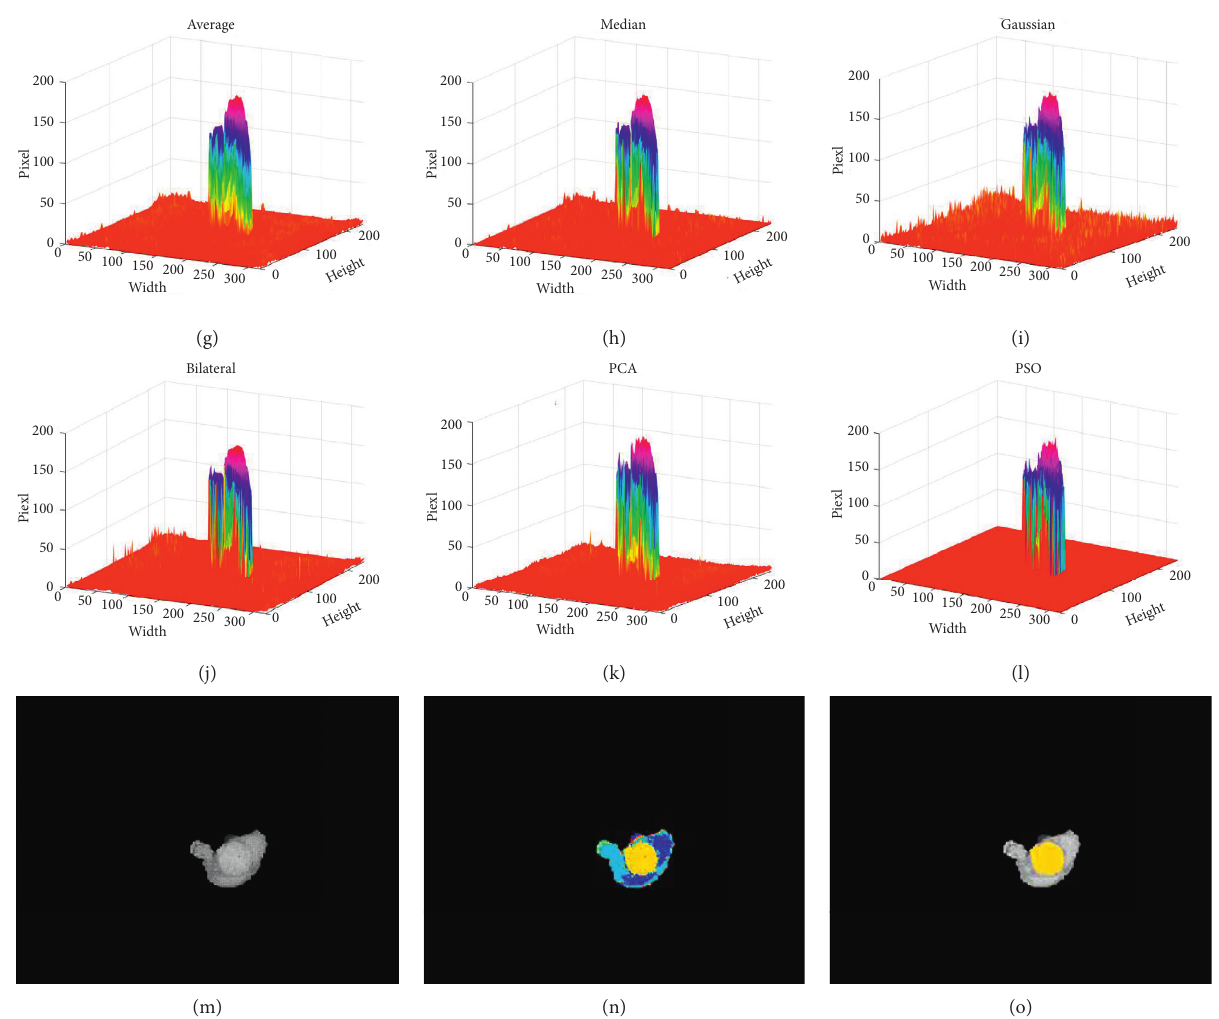
Figure 2: Representative images at each stage. (a, b) The depth images represented by HSV format. (c, d) The grey image corresponding to the depth images in (a, b), respectively. (e) The result of difference algorithm. (f) The 3D perspective view of the result in (e). The representative results (represented in 3D perspective view) using the different denoising algorithms: (g) average filtering, (h) median filtering, (i) Gaussian filtering, (j) bilateral filtering, and (k) two-stage PCA filtering. (l, m) The PSO denoising results in 3D and 2D, respectively. (n, o) The results obtained by the segmentation algorithm based on